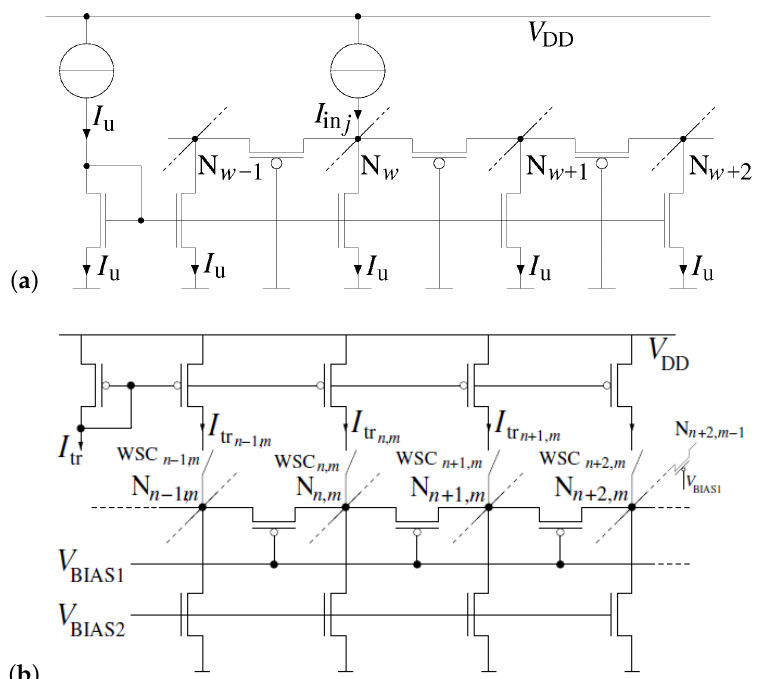
Figure 2. The analog neighborhood mechanism: ( a ) originally proposed by Peiris in [39], ( b ) after our modifications